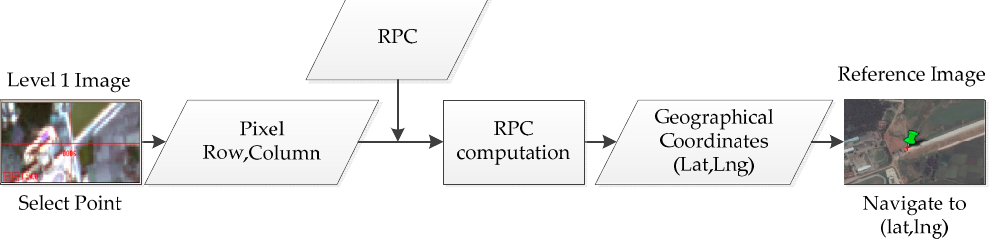
Figure 2. This shows the process of GCP prediction. A potential feature/point is selected from the GF-4 Level 1 image, and the reference data is then navigated to the predicted location (the junction point of the red cross located at the point of the green pushpin in the reference image).